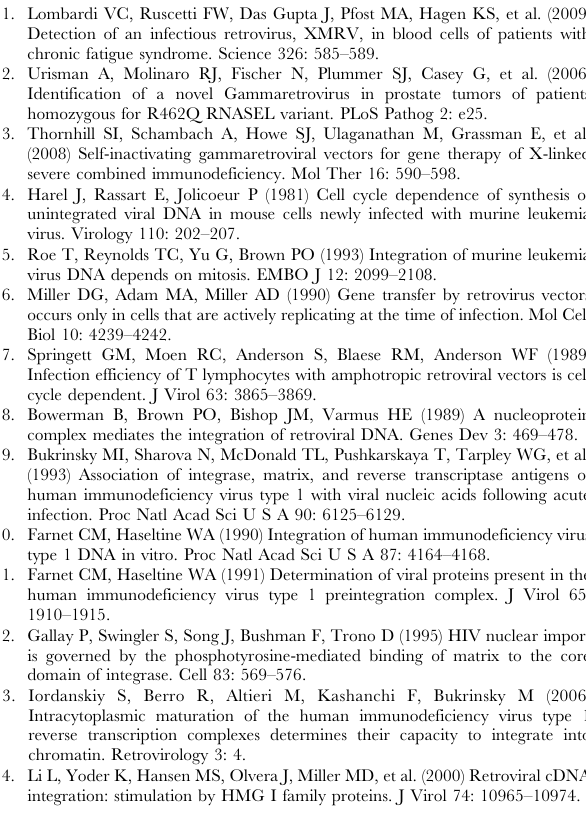
Figure S2 Intracellular distribution of GFP and GFP- Bcl-xL proteins observed in PC12 cells transduced with gammaretroviral vectors. PC12 cells transduced with con- centrated viral vector particles containing either the RT43.2GFP genome ( A ), or the RT43.2GFPBcl-xL genome ( B ). GFP is distributed throughout the entire cell, whereas GFP fused to the Bcl-xL protein is redistributed to cytoplasmic region consistent with Bcl-xL protein distribution [38]. Fluorescent images were taken on a Leica inverted microscope using iVision software at 20 6 magnification. Calibration bar =50 m m. Enlarged inset areas are outlined with red